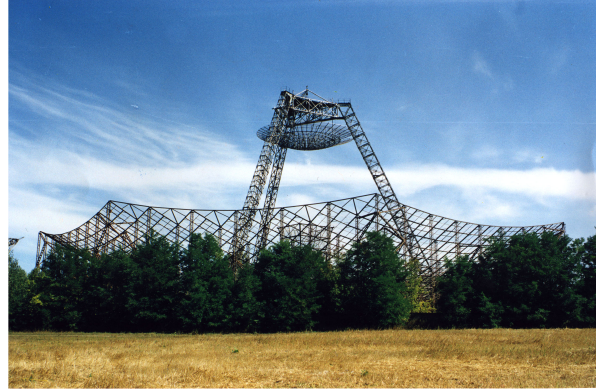
Figure 4. The IS radar with the 100-m parabolic